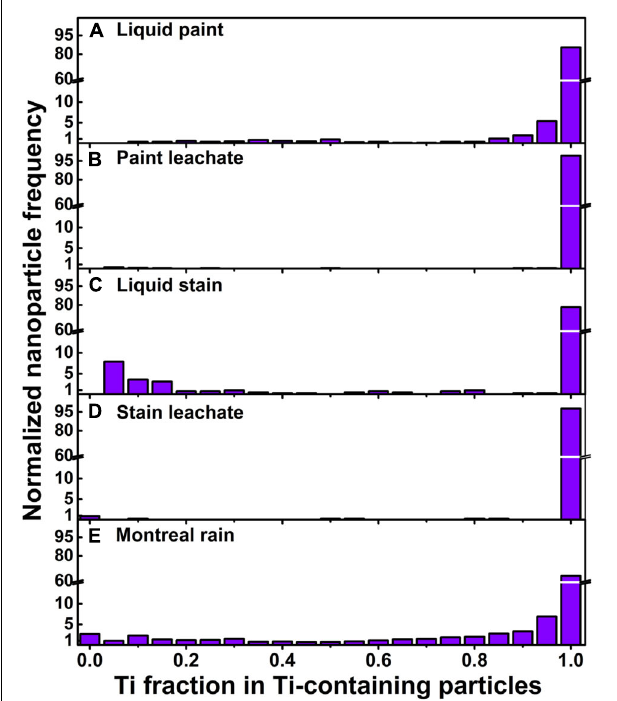
FIGURE 6 | Elemental fractions of Ti in Ti-containing NPs for (A) liquid paint (diluted in Milli-Q water), (B) paint leachate, (C) liquid stain (diluted in Milli-Q water), (D) stain leachate, and (E) Montreal rainwater. Measurements were performed using a SP-ICP-TOF-MS. Under the described conditions, a Ti fraction of 1 implies that the NP is primarily composed of Ti (or TiO 2 , i.e., single metal), whereas fractions < 1 indicate the presence of additional metals within the NP or agglomerate. Paint and stain leachates were collected during accelerated weathering experiments of the coated panels in Milli-Q